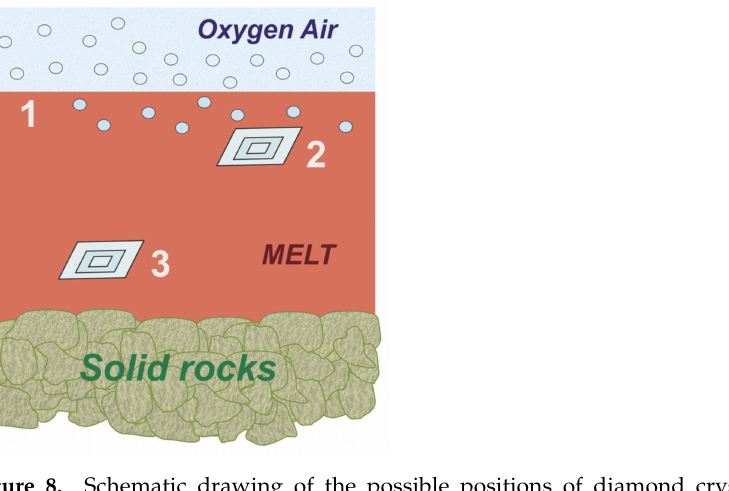
Figure 8. Schematic drawing of the possible positions of diamond crystals in molten rocks of an impact crater: (1)—surface of melt; (2)—crystal near the surface: mainly hexagonal or round pits; (3)—crystal deep within molten rock: irregular randomly oriented pits produced by surface